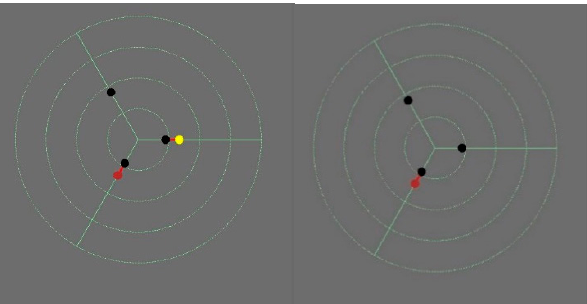
Figure 12. The two initial states used to generate the path shown in Figure 13. The only difference is the downhole sliding friction (yellow dot), larger than its estimated counterpart in the first state, and equal to it in the second one.